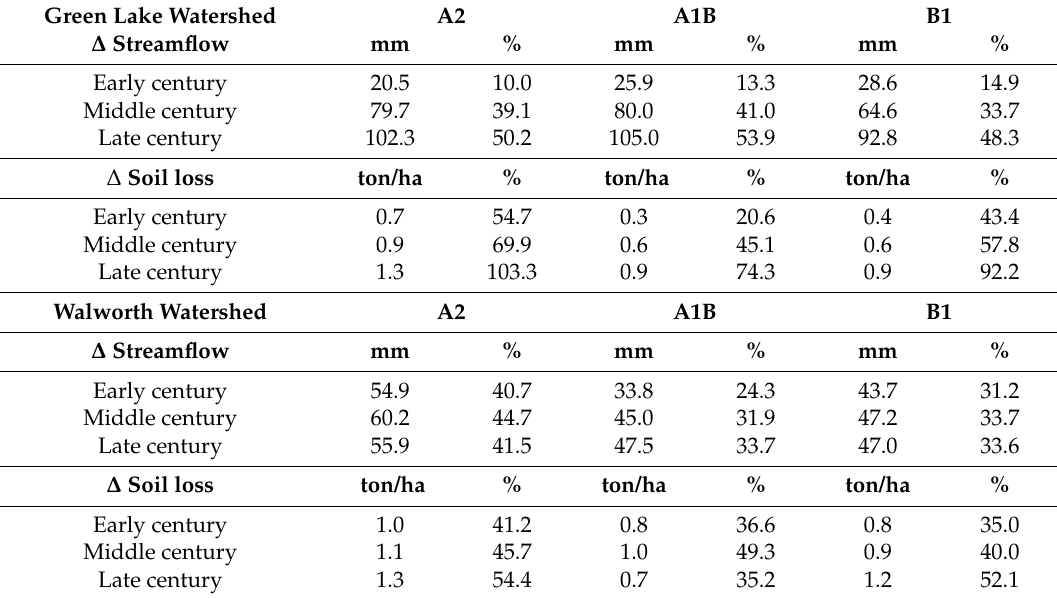
Table 6. Change percentage in annual streamflow (as a depth) and soil loss relative to the base period for three future climate